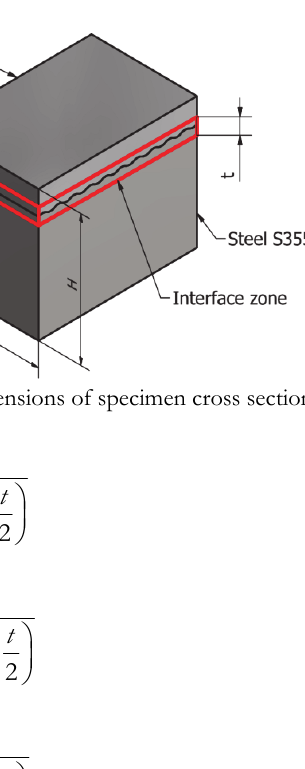
Table 2: Mechanical properties of the interface zone.